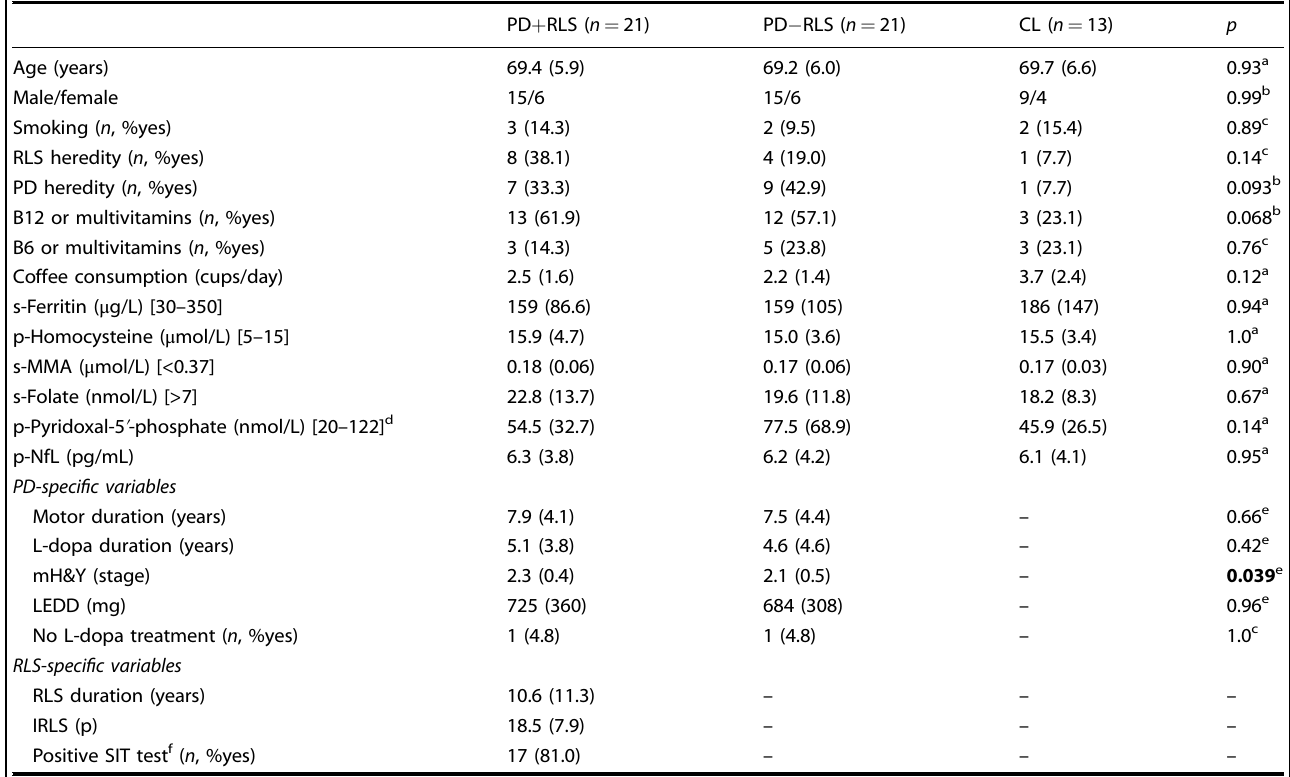
Table 1. Demographic, clinical, and biochemical characteristics of the study